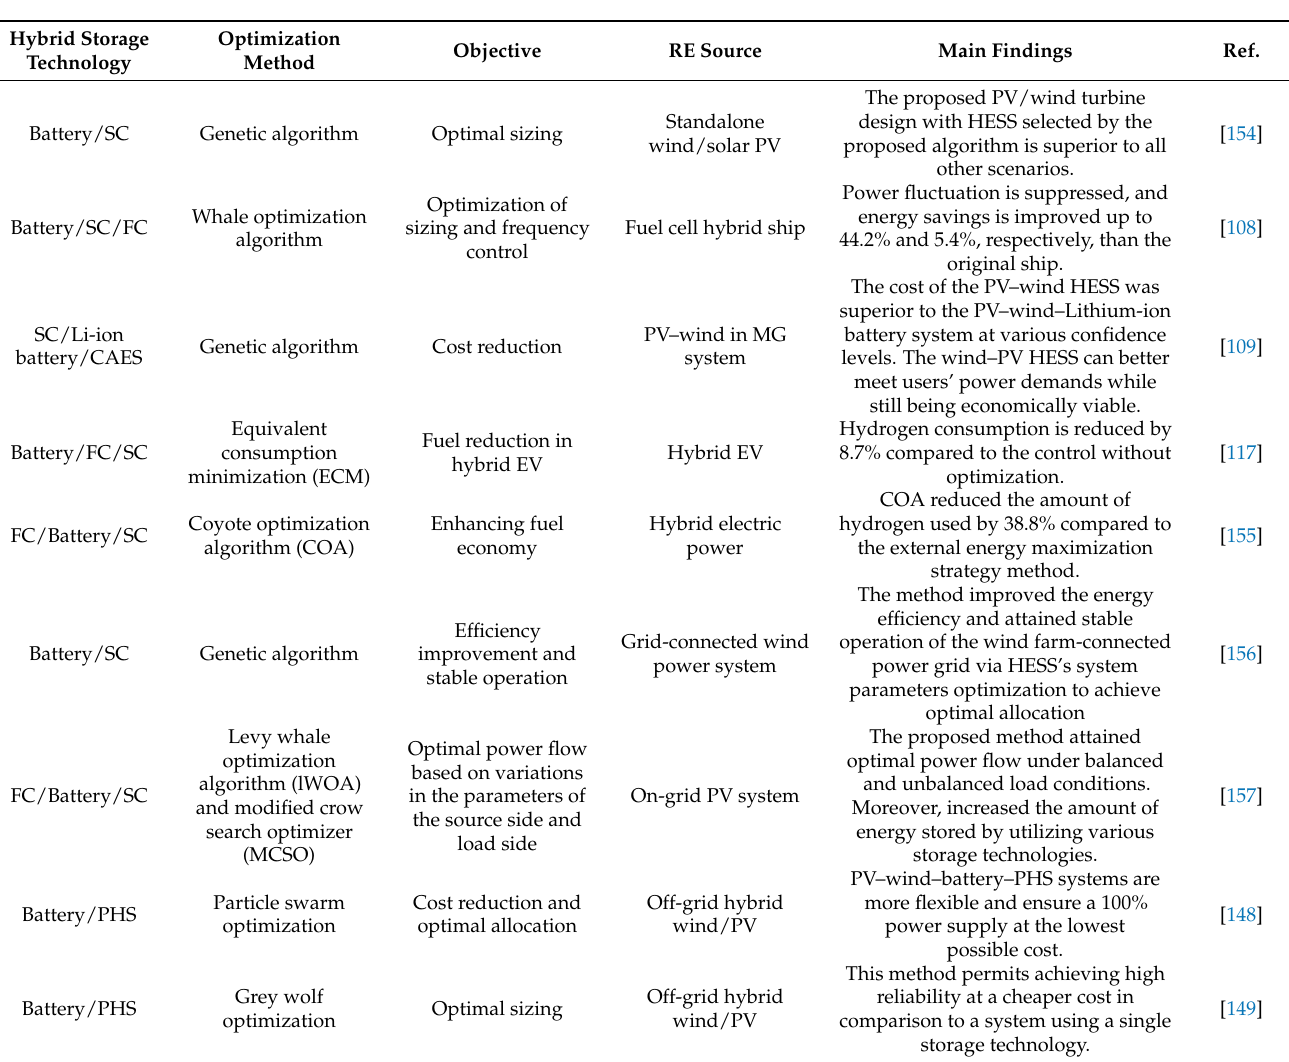
Table 6. The critical review analysis of the recent optimization methods for HESS-integrated RE sys-